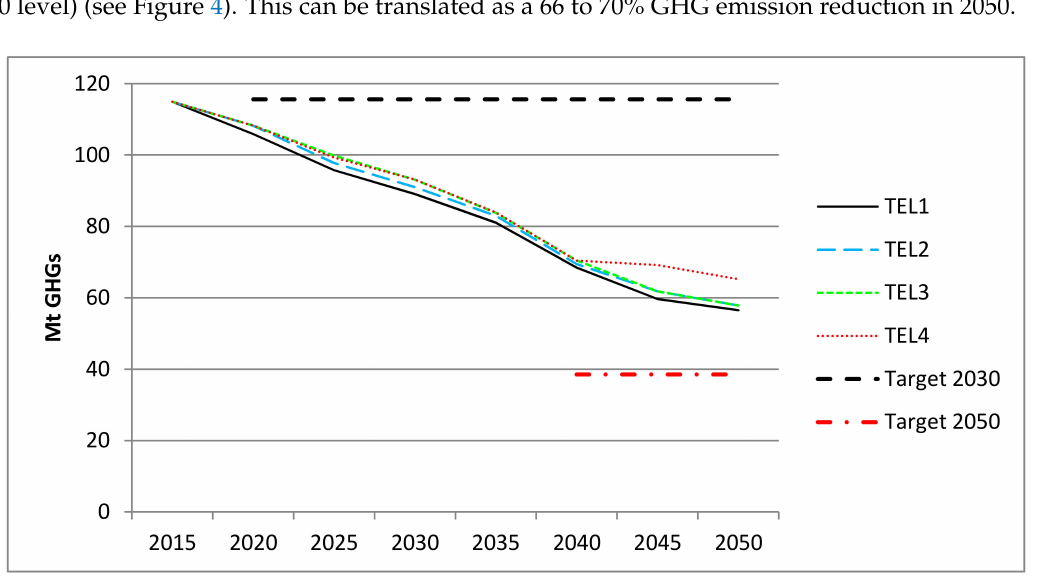
Figure 4. GHG emissions in assumption set BL until 2050 in all 4 TEL